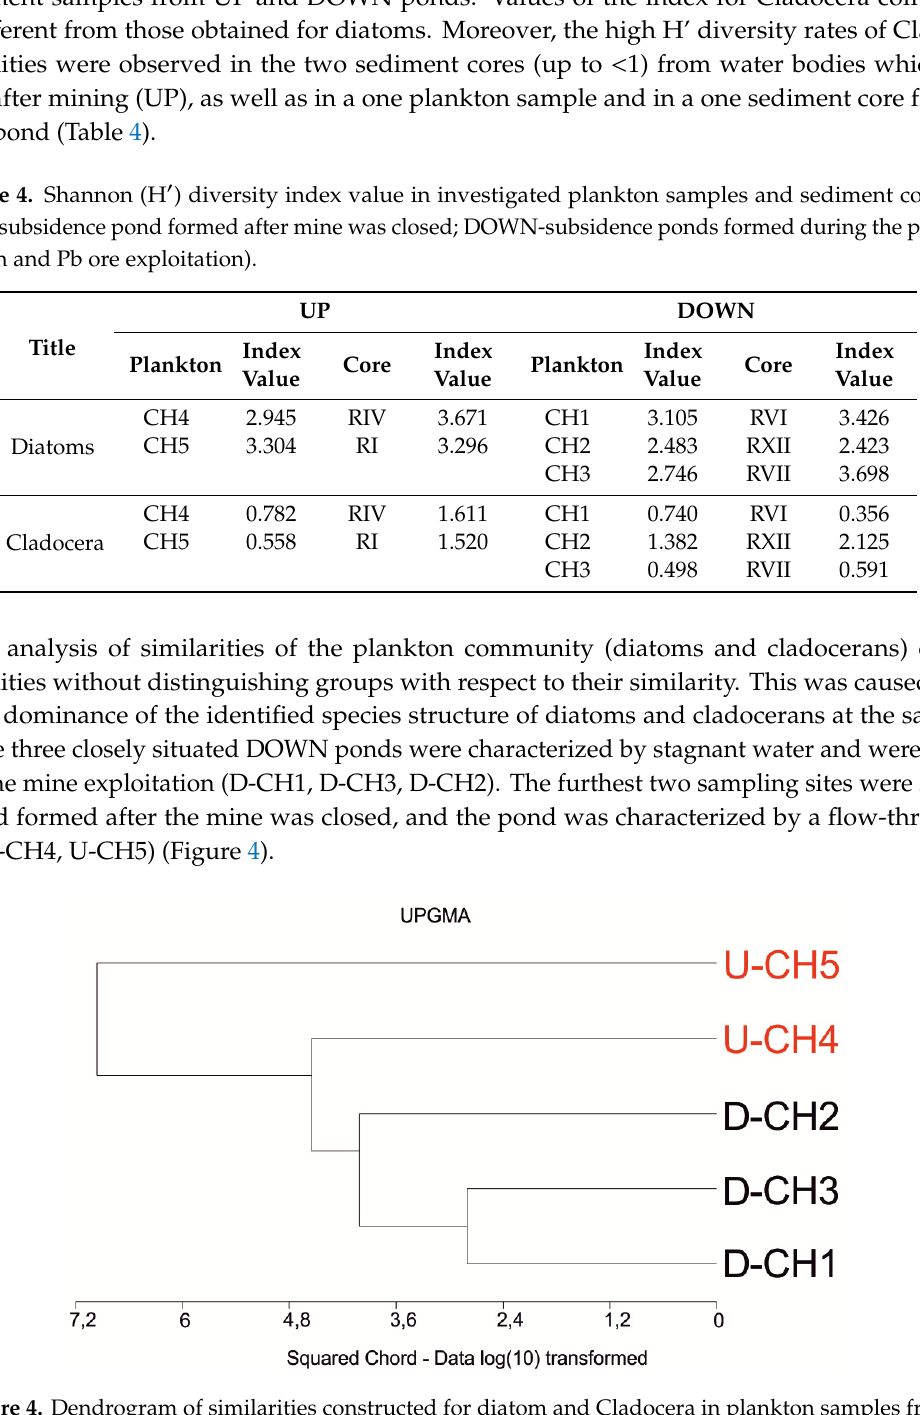
Figure 4. Dendrogram of similarities constructed for diatom and Cladocera in plankton samples from pond, created after mine was closed (UP) (U-CH5, U-CH4) and ponds existed during mine exploitation (DOWN) (D-CH3, D-CH2, D-CH1).